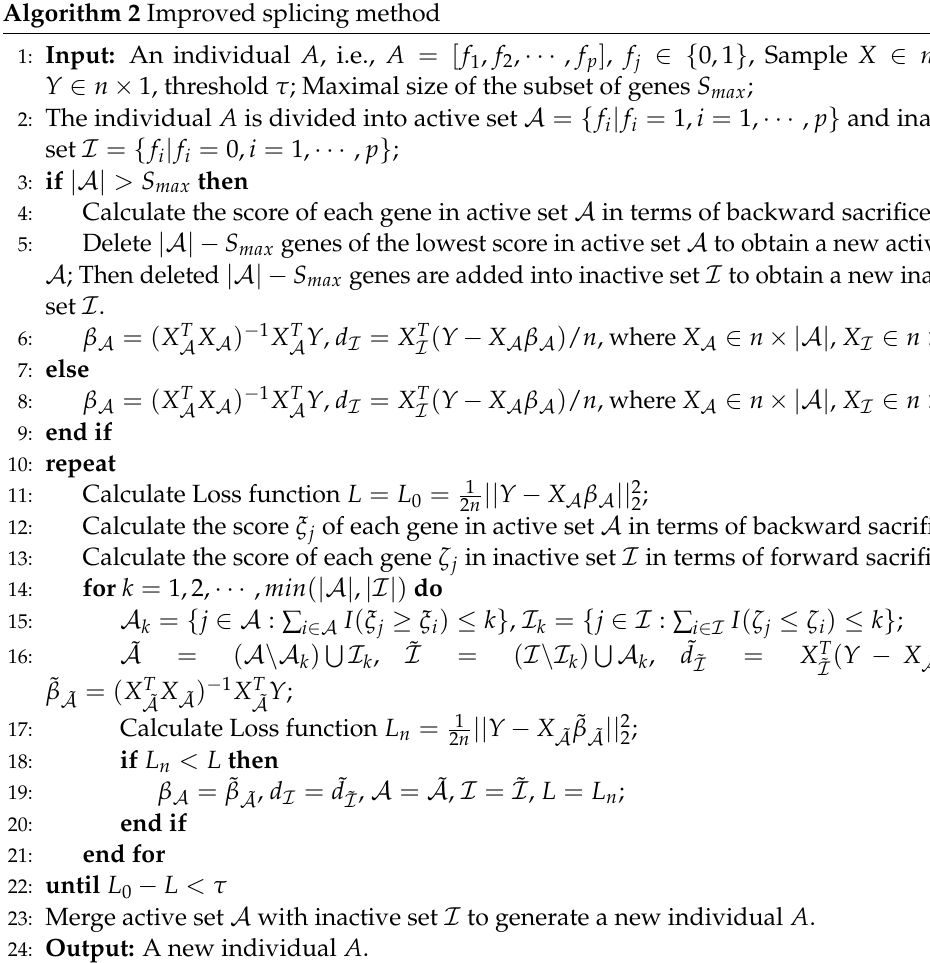
Algorithm 2 Improved splicing